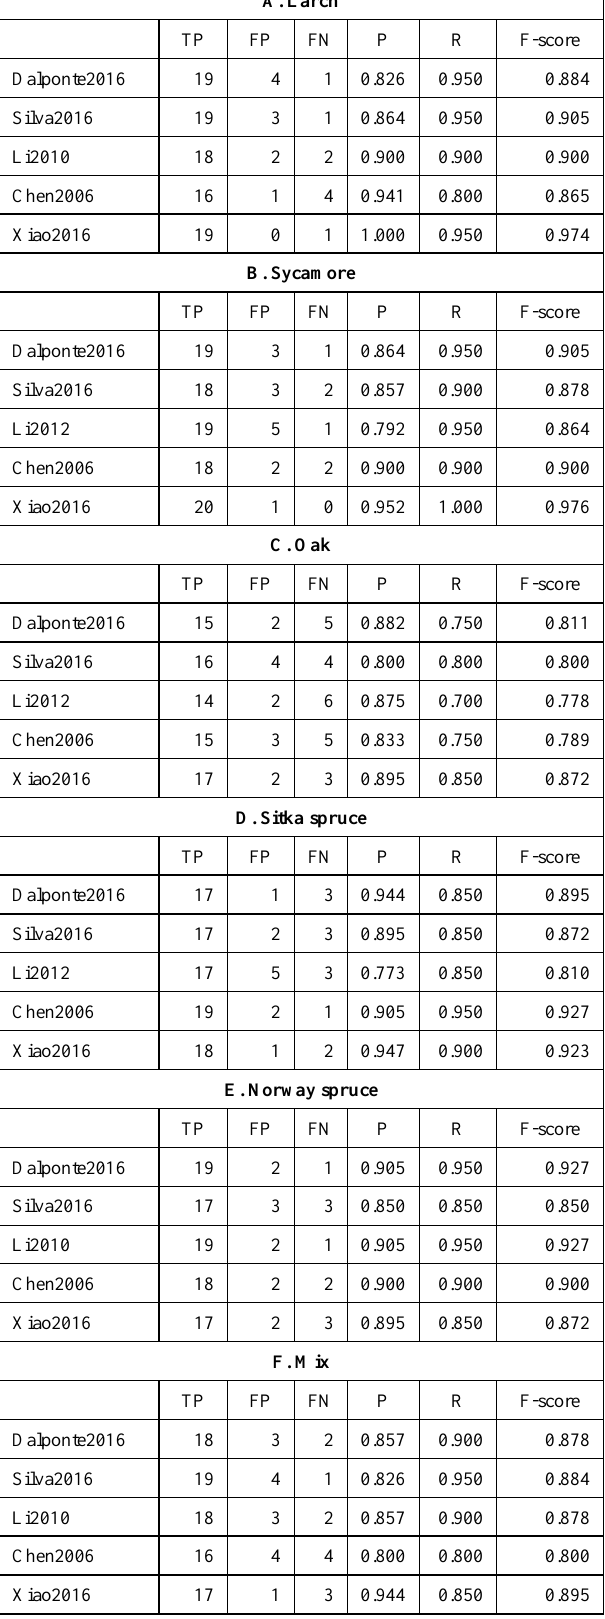
Table 1. Results of tree detection across all the plots with parameters calibrated for the best outcome (Test 1). TP – true positive, FP – false positive, FN – false negative, P – precision, R -